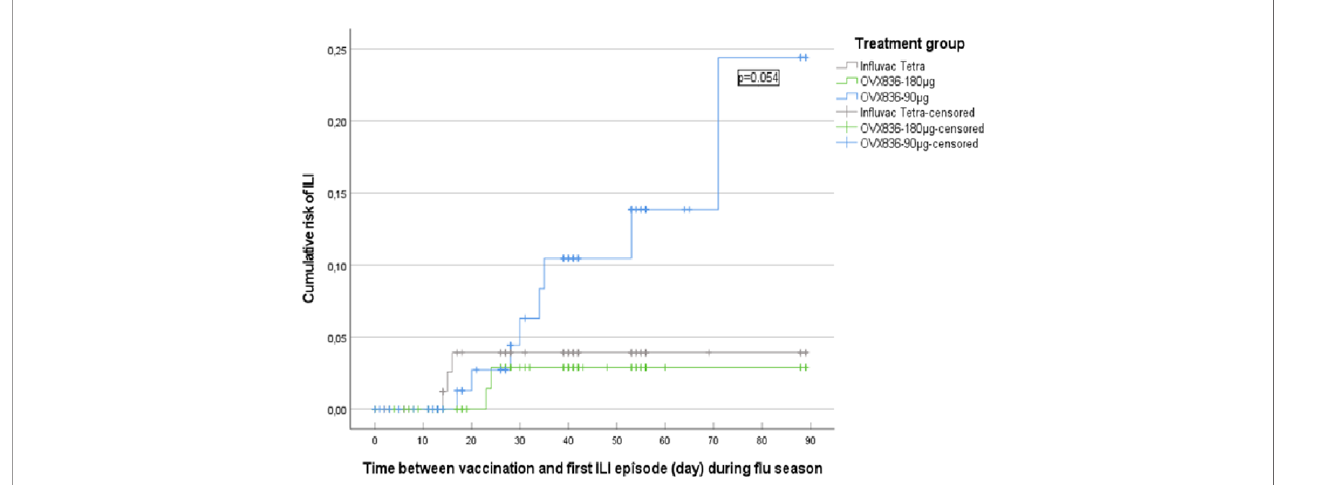
FIGURE 5 | Kaplan-Meier survival analysis of the cumulative risk of in fl uenza-like illness (ILI) as a function of time between vaccination and fi rst ILI episode (day) during the in fl uenza season (de fi ned as the period between 02 December 2019 and 09 March 2020), from 14 days post-vaccination onward, in the three treatment groups (In fl uvac Tetra ™ , OVX836 90µg and OVX836 180µg; modi fi ed intention-to-treat cohort corresponding to the safety cohort). Log-rank test showed a p=0.054 for the comparison between In fl uvac Tetra and OVX836